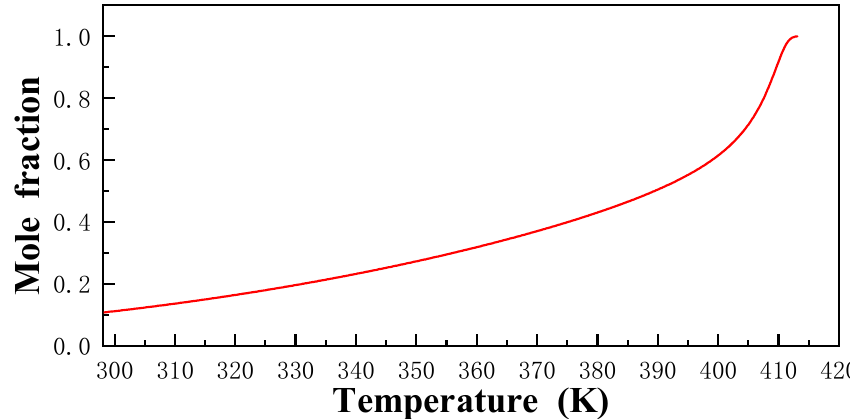
Figure 10. The solubility of ethanol in insulating oil.